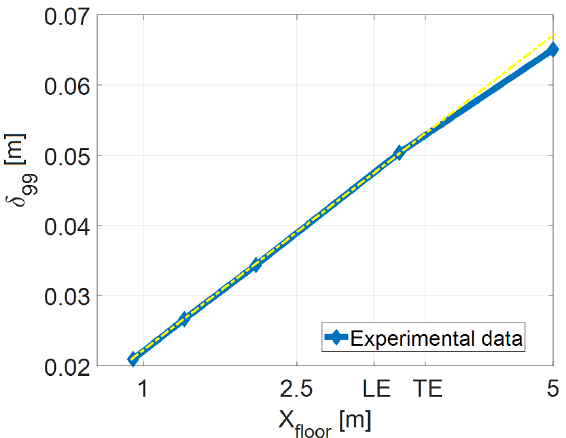
Figure 8. Boundary-layer growth with respect to the stream-wise direction over the wind tunnel floor; The yellow line is a linear function fitted to the boundary layer